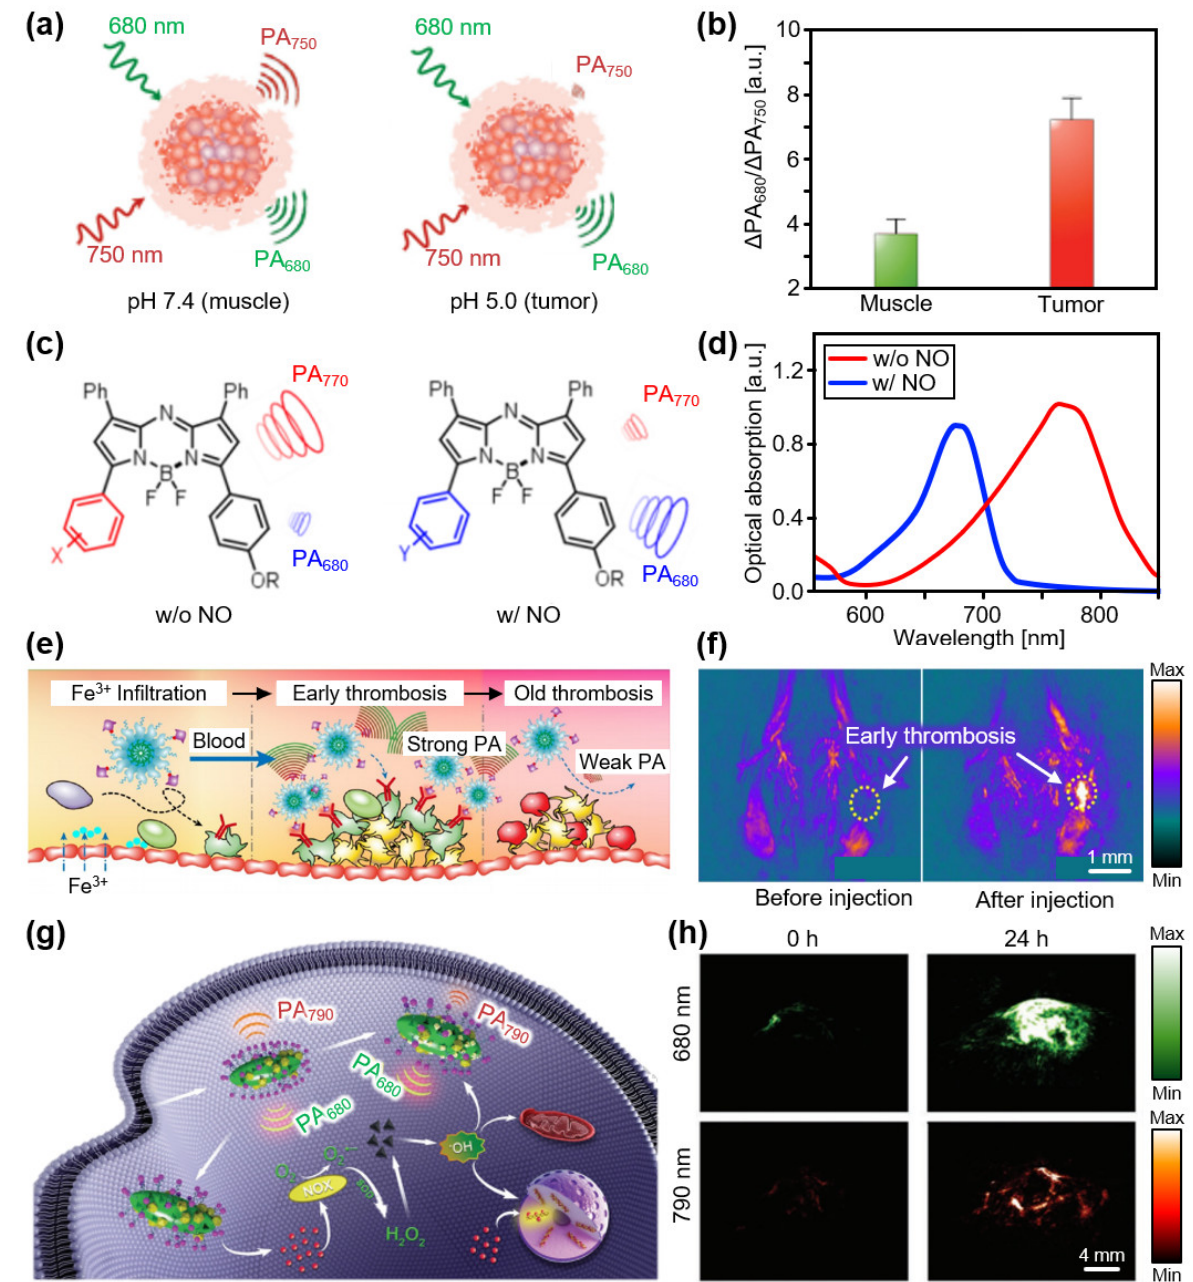
Figure 2. Contrast-enhanced PA imaging of organic nanostructures. ( a ) Schematic illustration of a pH-sensitive nanoprobe. ( b ) Ratiometric PA signals of a muscle (pH 7.4) and tumor (pH 5.0). Reprinted with permission from Ref. [84]. 2016, Wiley. ( c ) Schematic illustration of signal switching of an NO-activated nanoprobe. ( d ) Optical absorption spectra of a nanoprobe with and without NO. Reprinted with permission from Ref. [85]. 2018, ACS Publications. ( e ) Schematic illustration explaining the mechanism of PA signal generation in early thrombosis after injection of the PDI-based nanoparticles. ( f ) Contrast-enhanced PA images of mice before and after injection of PDI-based nanoparticles. Reprinted with permission from Ref. [86]. 2017, ACS Publications. ( g ) Schematic illustration of the PA signal switching that indicates ROS generation. ( h ) Contrast-enhanced PA images at 680 and 790 nm before and 24 h after injection. PA, photoacoustic; NO, nitric oxide; PDI, perylene diimide; ROS, reactive oxygen species. Reprinted with permission from Ref. [87]. 2018,